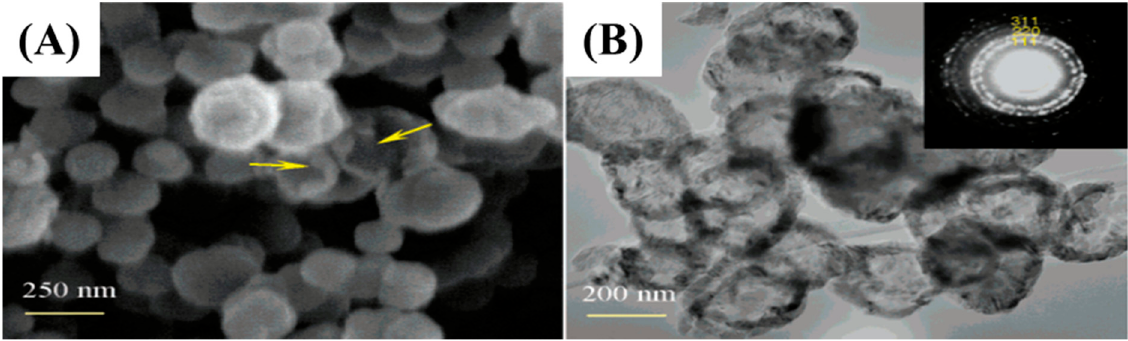
Figure 3. TEM images ( A – C ) of SiC NPs at different reaction temperatures [44].